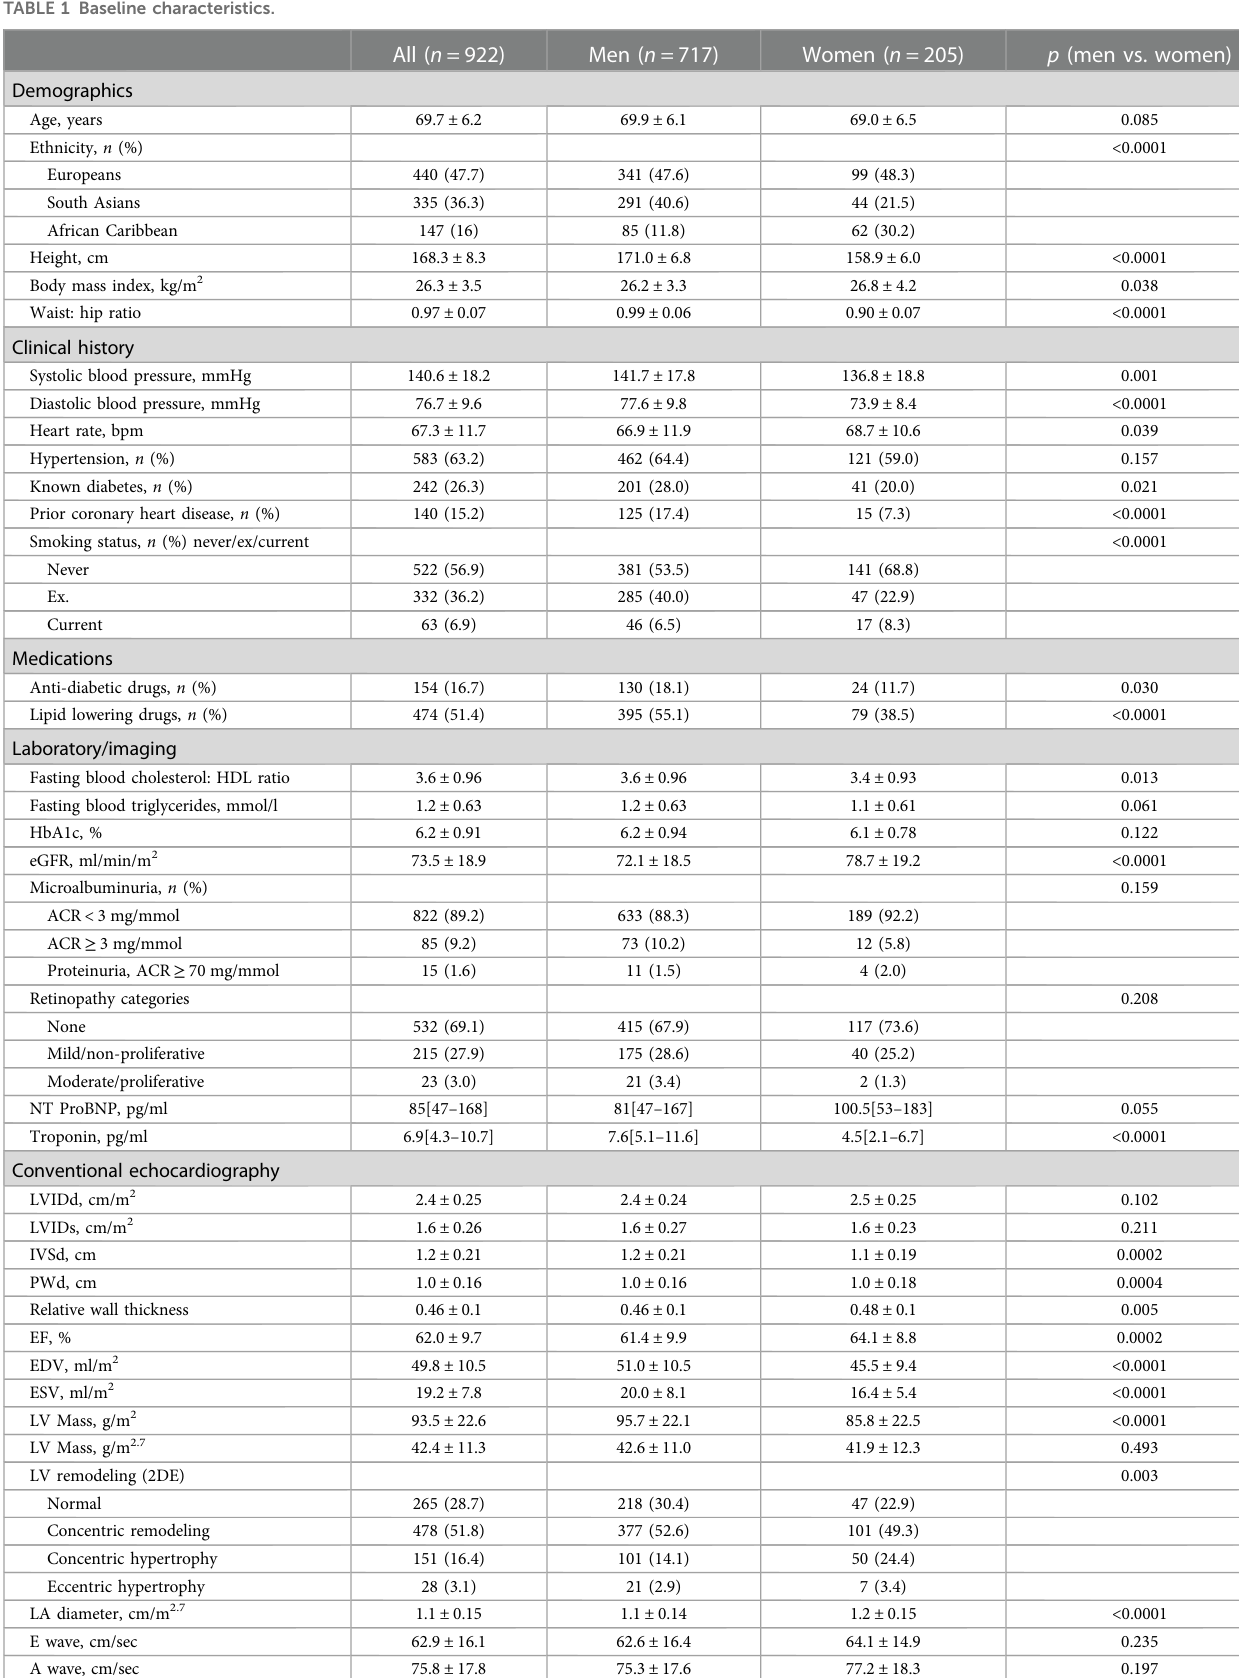
TABLE 1 Baseline